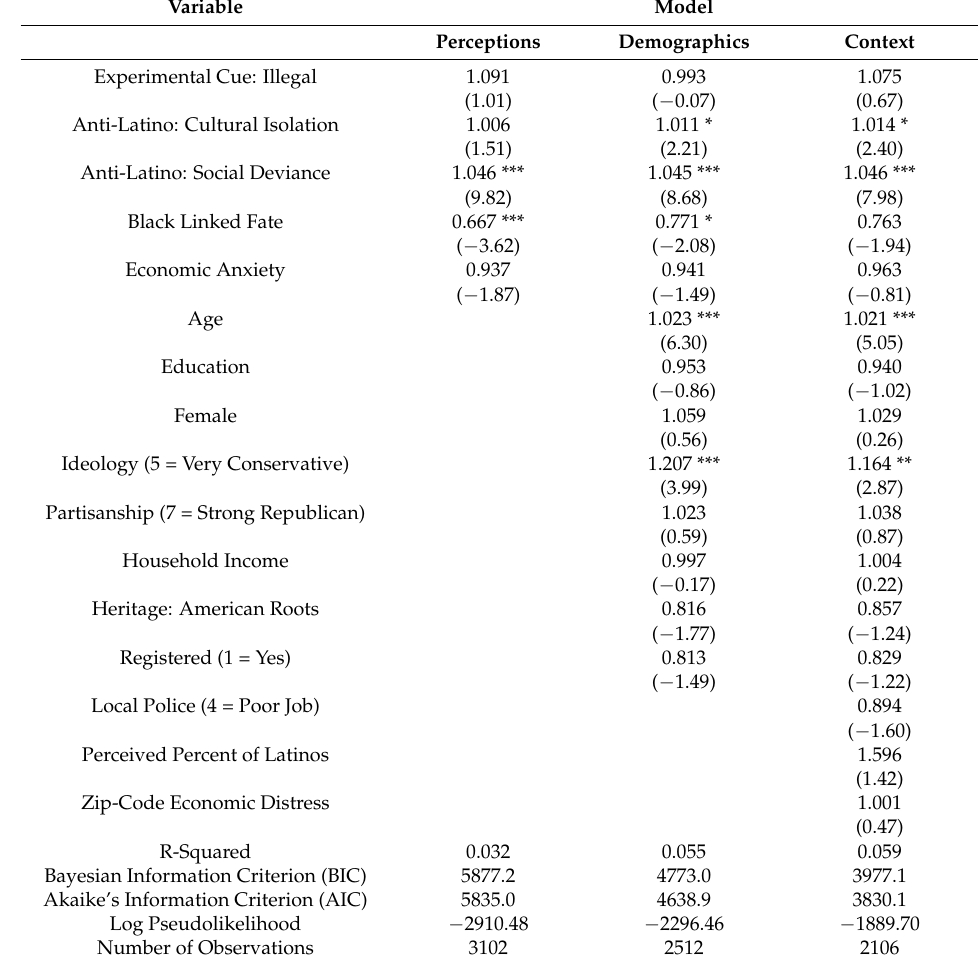
Table 3. Odds ratios from the ordinal logistic models of positions on border security funding by anti-Latino perceptions, demographics, linked fate, and experimental cue.